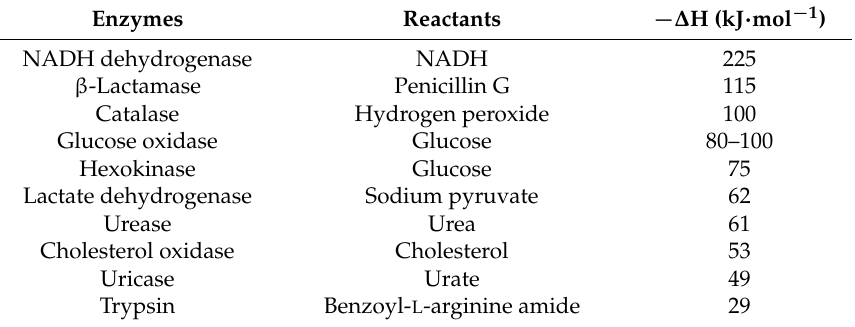
Table 3. The enthalpy changes for enzymatic